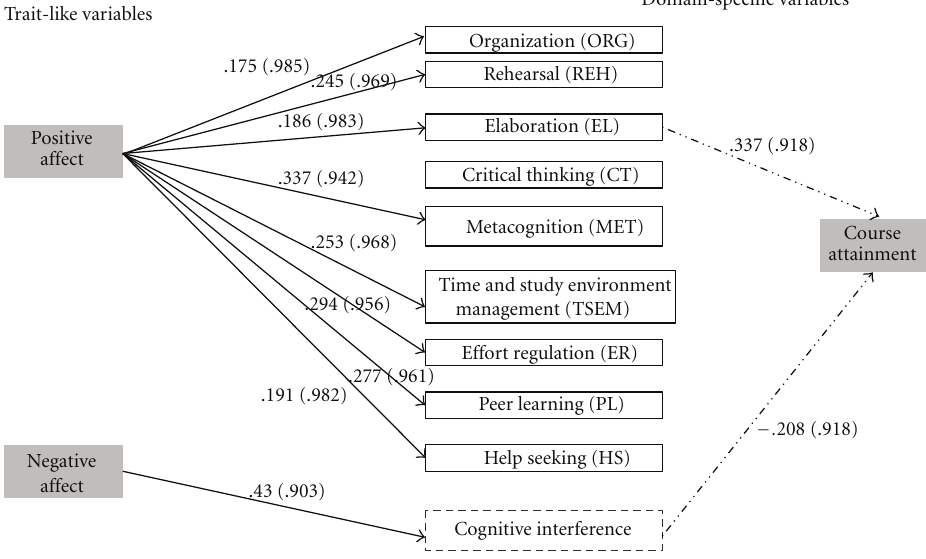
Figure 1: The final path model displaying the relationships among negative a ff ect, positive a ff ect, cognitive interference, self-regulated learning strategies, and course attainment in the didactics of mathematics subject matter. Note 1. All paths drawn indicate significant associations ( P < . 05). Note 2. Doted lines indicate direct e ff ects on course attainment. Note 3. Errors are given in parenthesis. Note